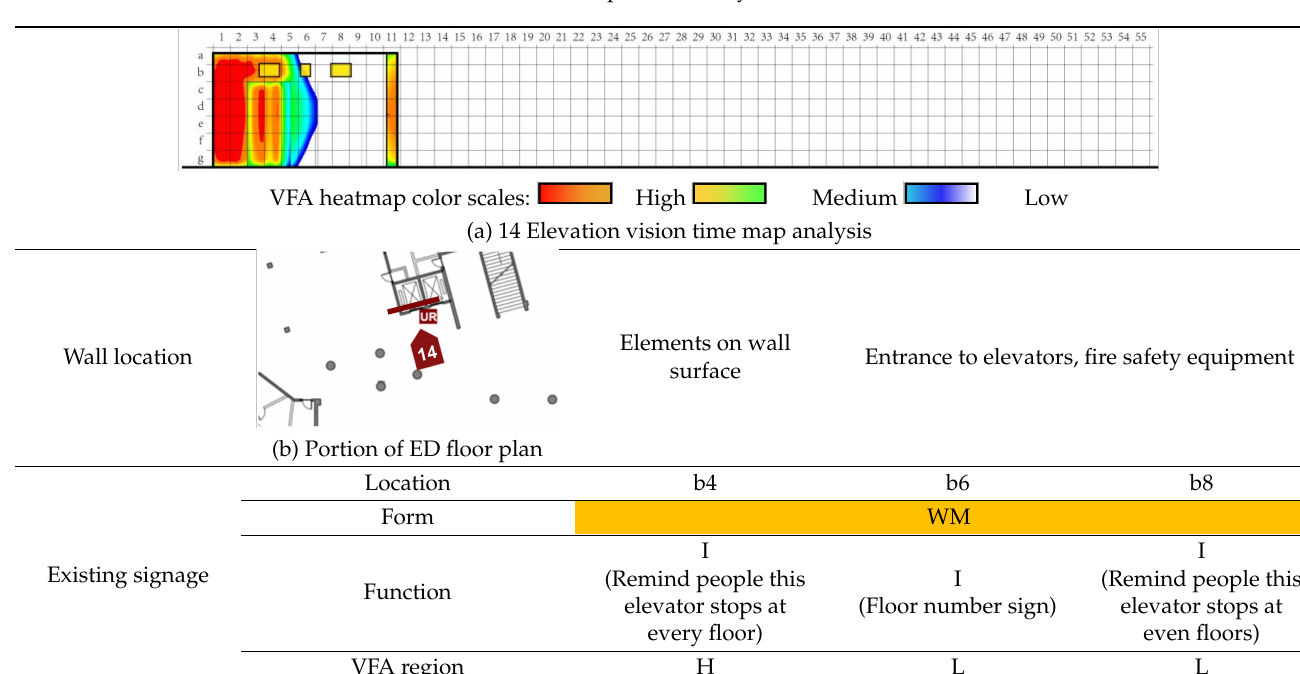
Table 18. 14 Elevation comparative analysis.